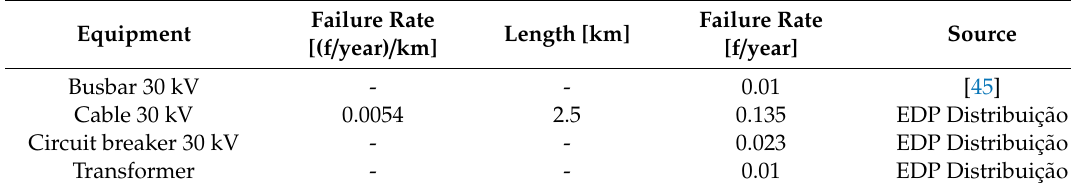
Table 4. Failure rates attributed to each power